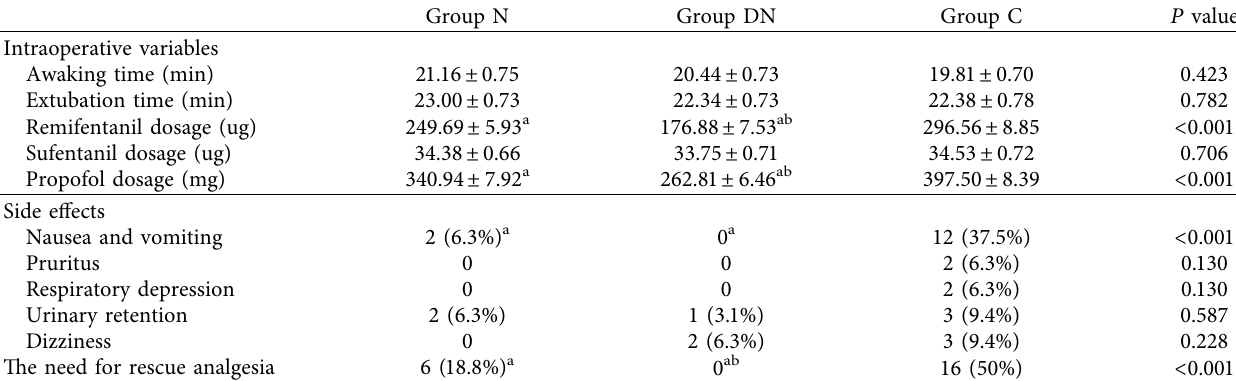
Table 4: Comparison of intraoperative variables, side effects, and the need for rescue analgesia in the three